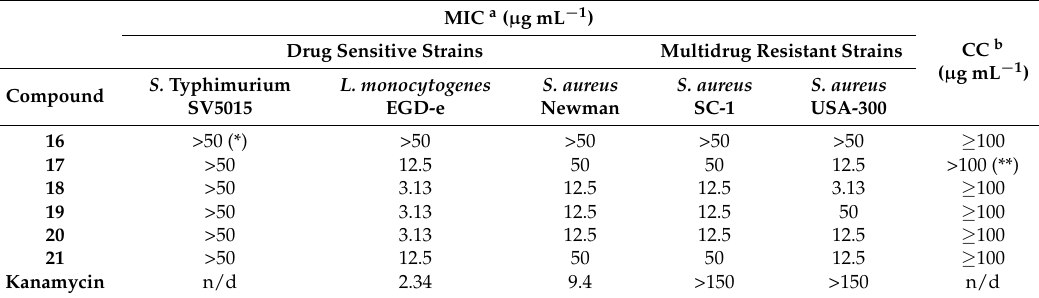
Table 1. Antibacterial activity and cytotoxicity of the test